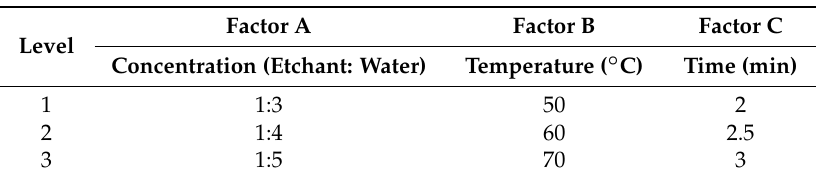
Table 2. Control factors and their levels.